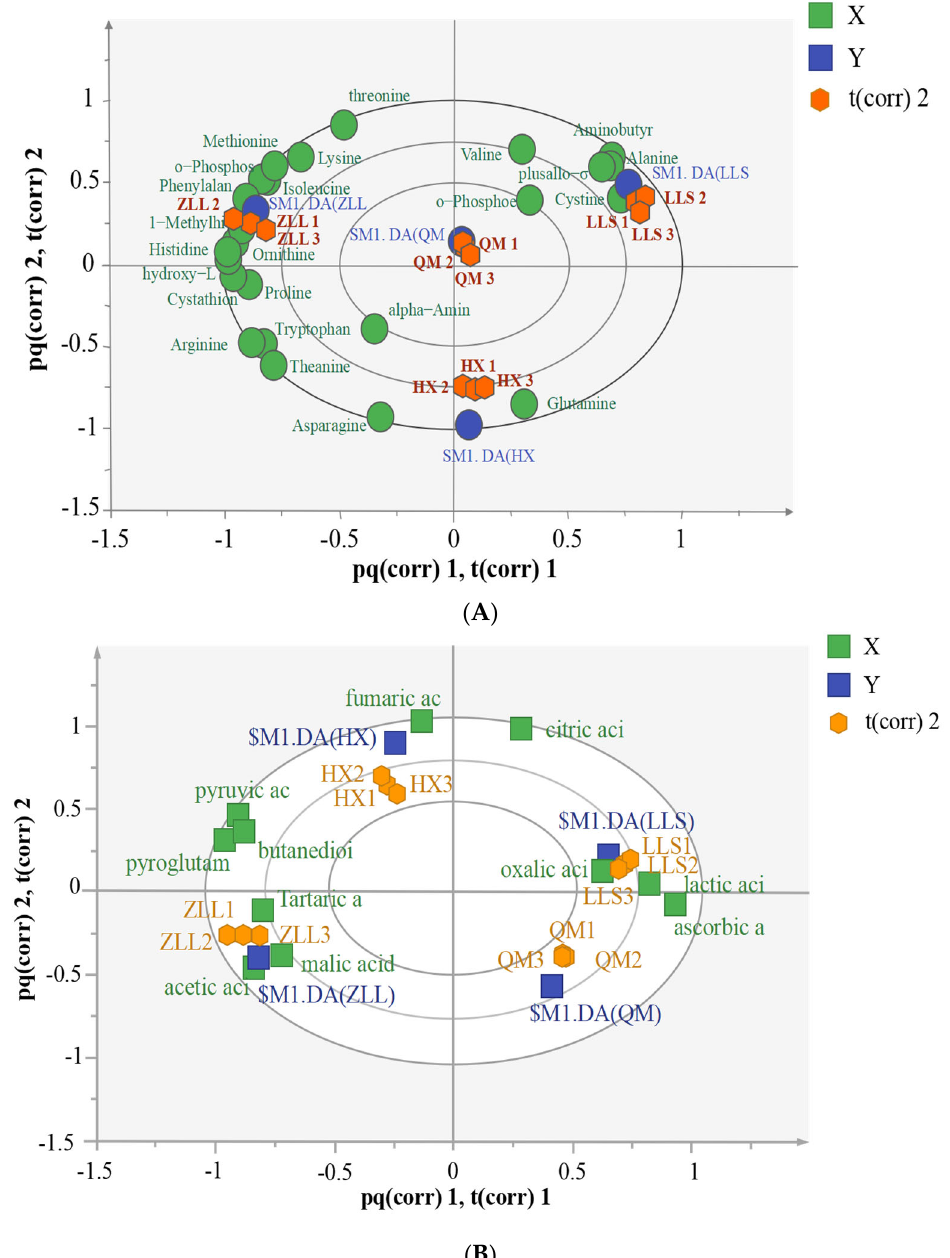
Figure 3. Targeted metabolome analysis. ( A ) amino acid biplot scores, ( B ) organic acid biplot score.